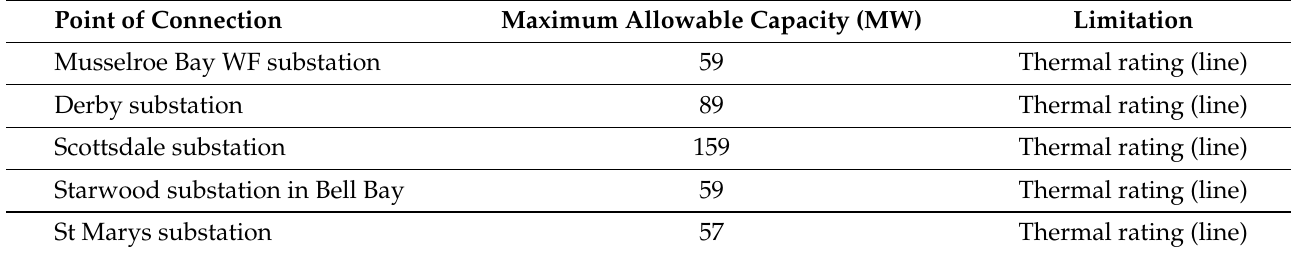
Table 4. Locational tidal HC at different locations in the Tasmanian network after upgrading nearby